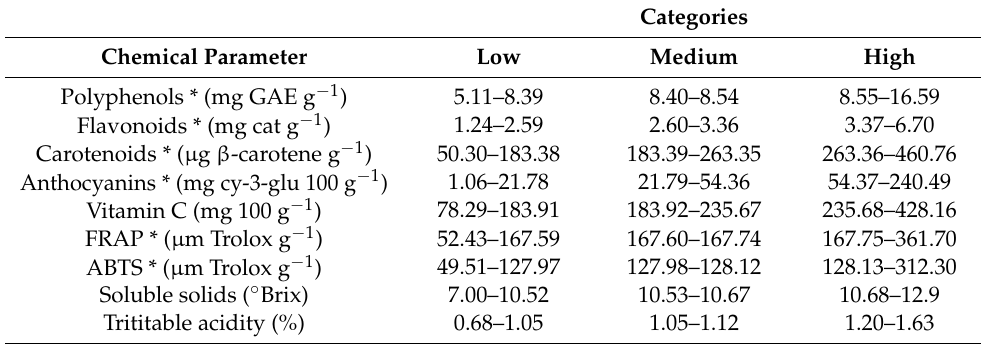
Table 2. Categories for the different chemical traits on the tree tomato breeding